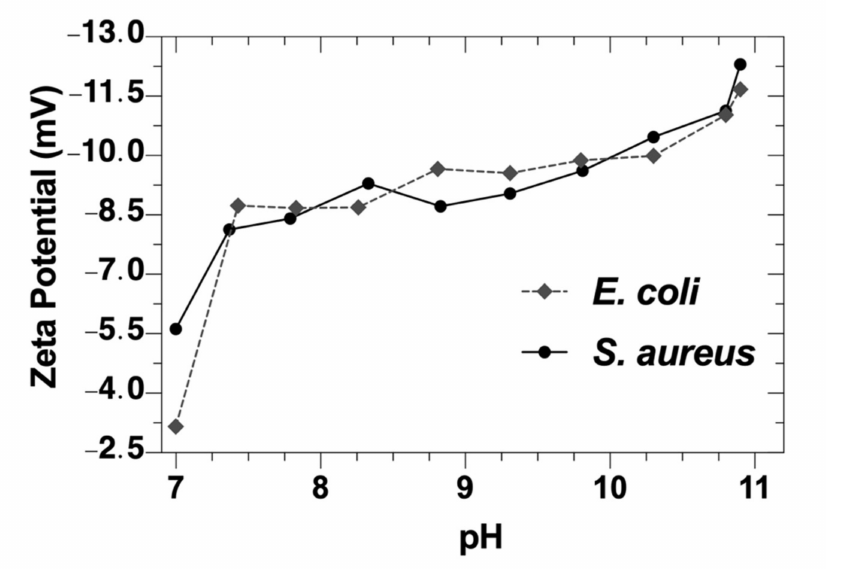
Figure 14. Average values of zeta potential of E. coli and S. aureus bacteria vs. pH of Mueller–Hinton culture broth.